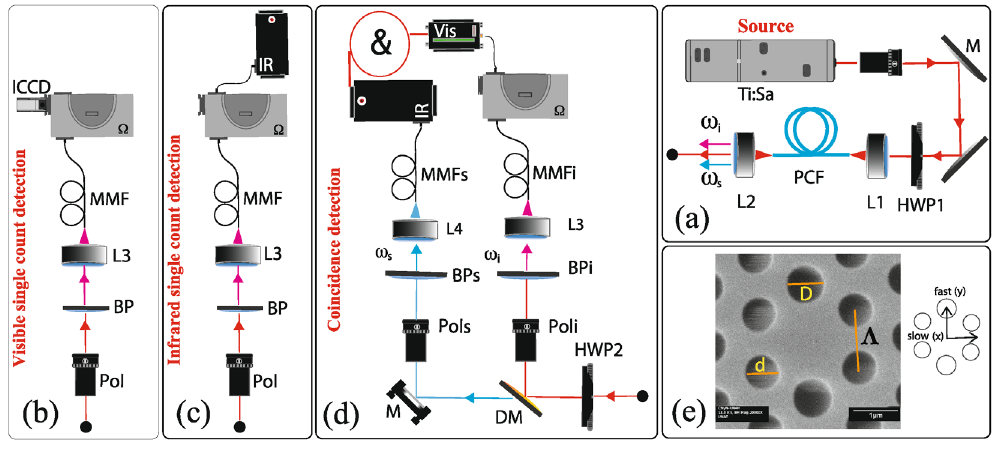
Figure 1. Experimental setup. SFWM photon pair source implemented in a polarization maintaining photonic crystal fiber ( a ). Spectrally-resolved photon counting scheme with spectral resolution for idler (visible) ( b ) and signal (infrared) modes ( c ). Spectrally-resolved coincidence-photon counting scheme, showing spectral resolution for the idler mode ( d ). Scanning electron microscope (SEM) micrograph of the fiber profile; for the chosen reference system the slow axis coincides with the horizontal axis, while the fast axis corresponds to the vertical axis ( e